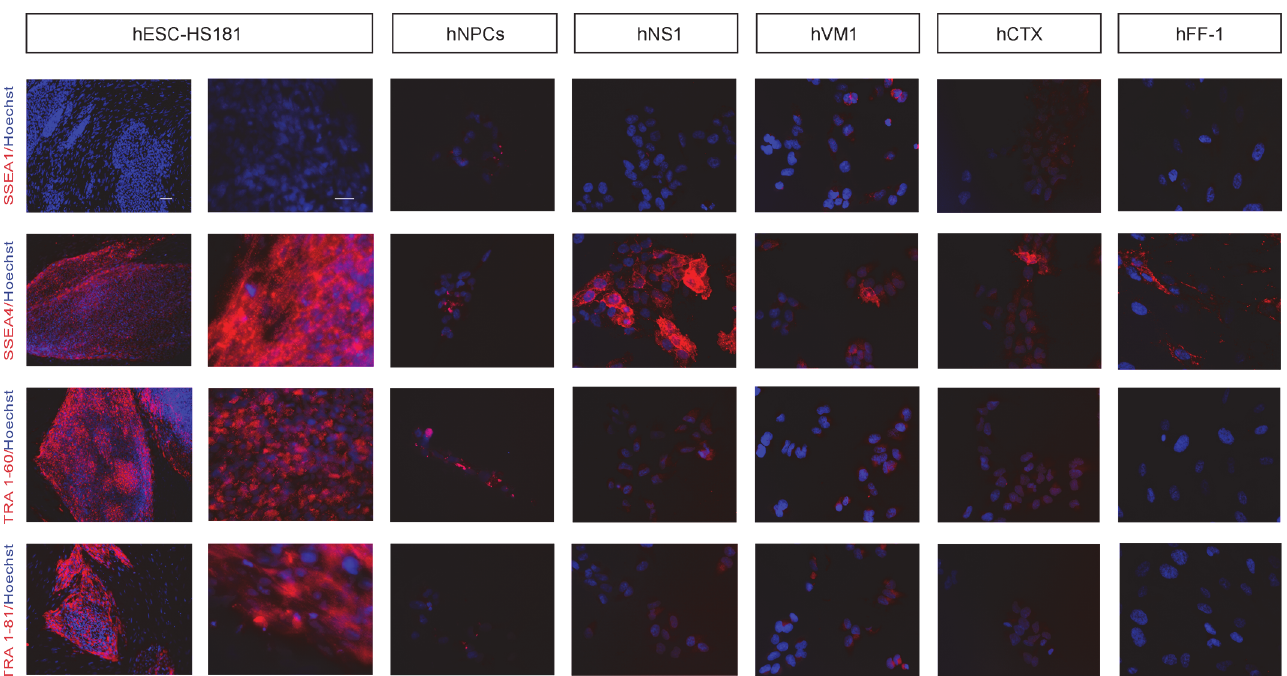
Fig 2. Immunocytochemistry of stemness surface markers. Staining was performed 48 hours following the last passage. From left to right: staining displayed by hESCs (HS181 line, low and high magnification), hNPCs, v-myc immortalized lines (hNS1, hVM1, and hCTX) and fibroblasts (hFF-1). From top to bottom the markers studied were: SSEA1, SSEA4, TRA1 – 60 and TRA1 – 81. Hoechst 33258 nuclear staining is shown in blue. Scale bar represents 100 μ m for hESCs in the left hand column (low magnification) and 25 μ m for all the other microphotographs.